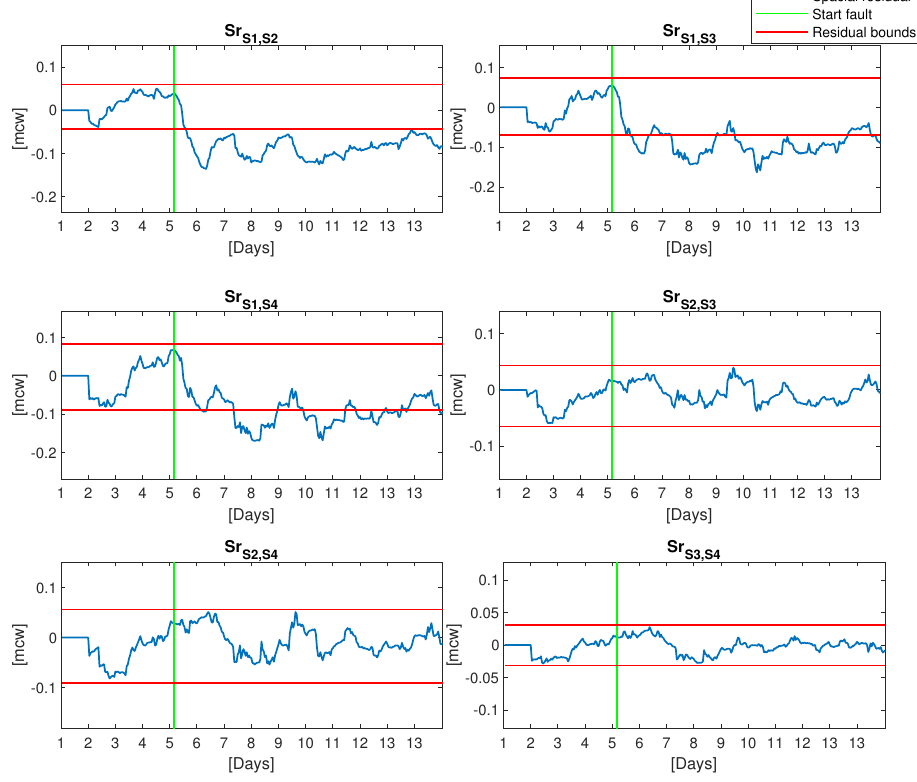
Figure 7. Graph of the spatial residual with a fault in sensor number